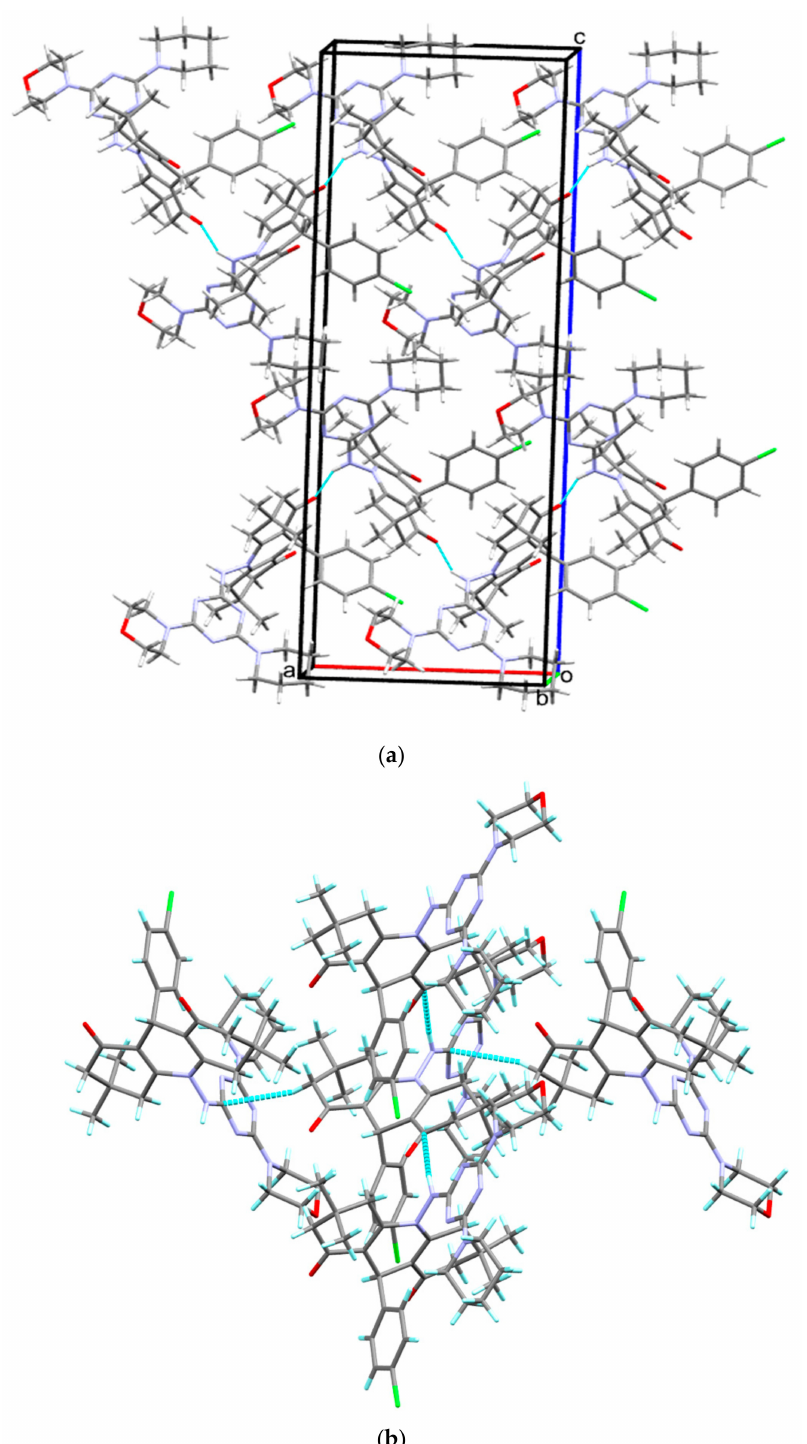
Figure 2. Crystal packing diagram of compound 4 . ( a ) The most important hydrogen bonding interaction (N-H ... O) is presented as dotted turquoise line. ( b ) The weak C-H ... π interactions are also presented in the same color in the lower part of this